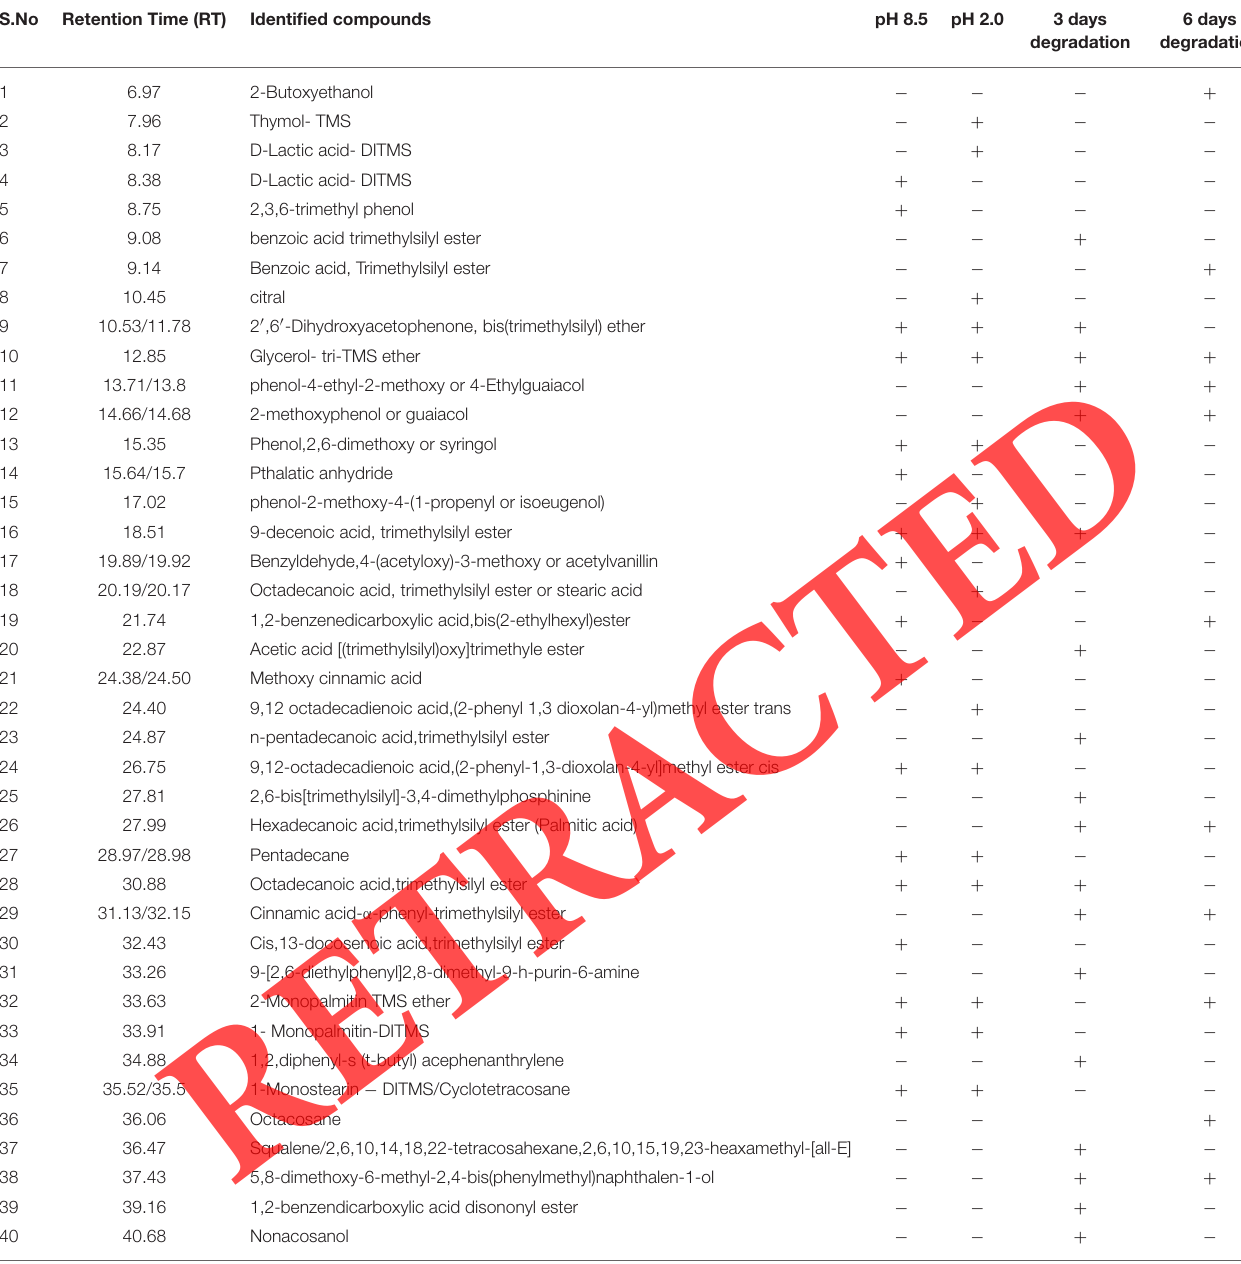
TABLE 2 | Identified residual organic pollutants by GC-MS in the TMS derivatized ethyl acetate extracts of pulp and paper mill effluent after secondary treatment in alkaline (pH, 8.5), acidic (pH 2), 3 days and 6 days of bacterial treatment. S.No Retention Time (RT) Identified